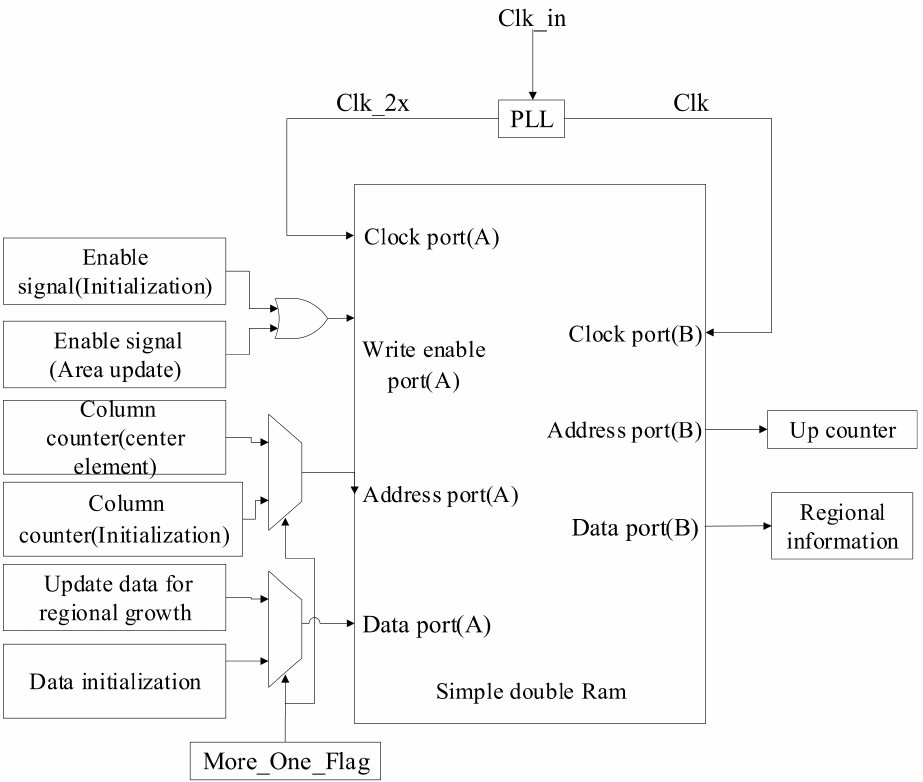
Figure 14. Construction of the RAM port signal. In order to ensure the correctness of subsequent calculations, the RAM is initialized before the area growth; that is, the initialization data is written through Port A. The timing of the key signals is shown in Figure 15.